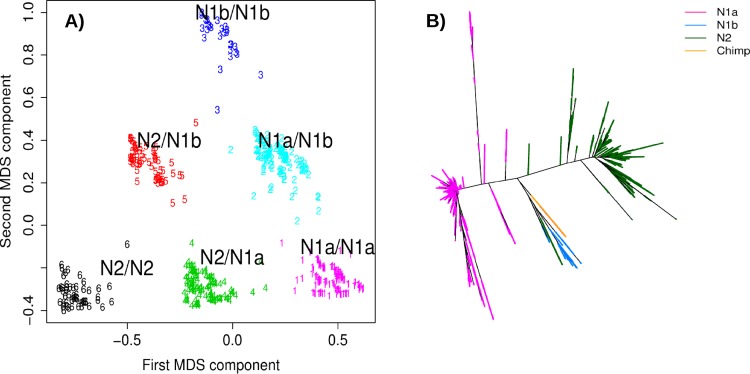
Haplotype structure of three clades in the N block.A) The MDS analysis in the CD region reveals three clusters that correspond to six different genotypes, with low Mendelian errors of transmission. B) NJ plot showing the phylogenetic relationships between N1a, N1b and N2. The chimp allele is found in the clade N1b.